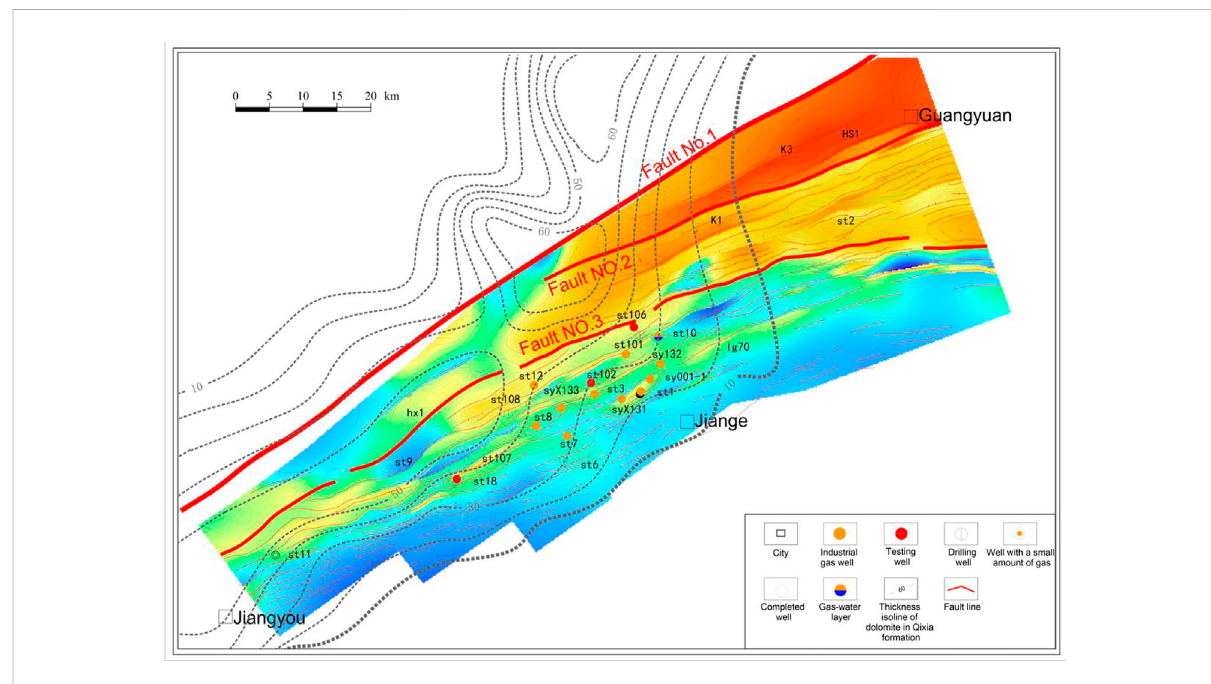
FIGURE 8 Distribution map of structural superimposed dolomite of the Qixia Formation in the northwestern Sichuan